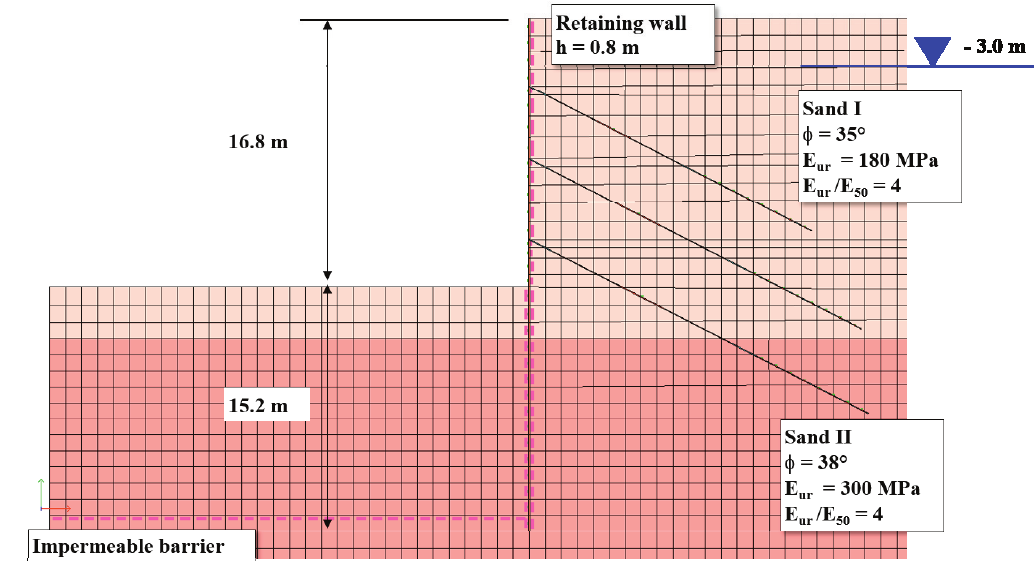
Fig. 4. Original problem statement for excavation in Berlin (Obrzud and Truty